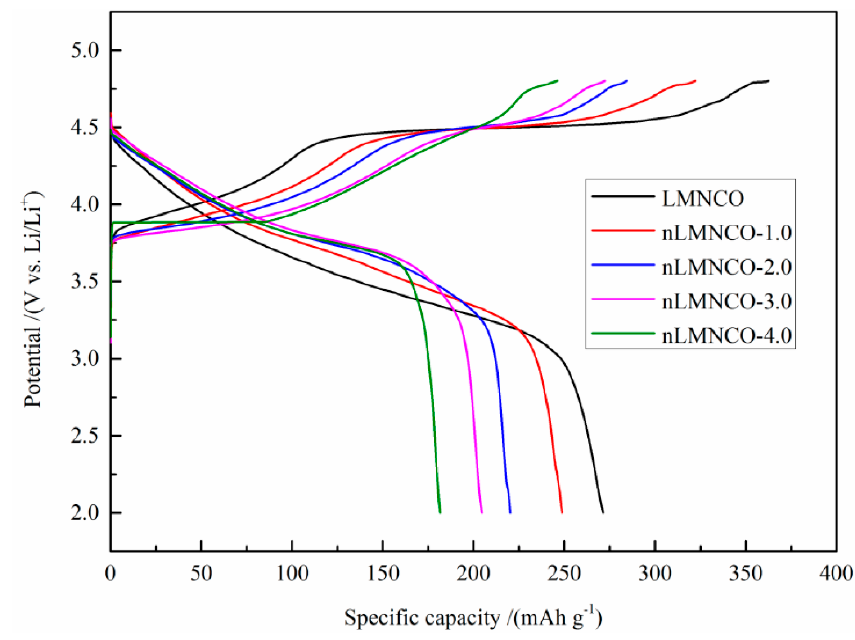
Figure 6. The initial charge/discharge profile of cathode materials at 0.1 C (1 C = 250 mA g − 1 ).